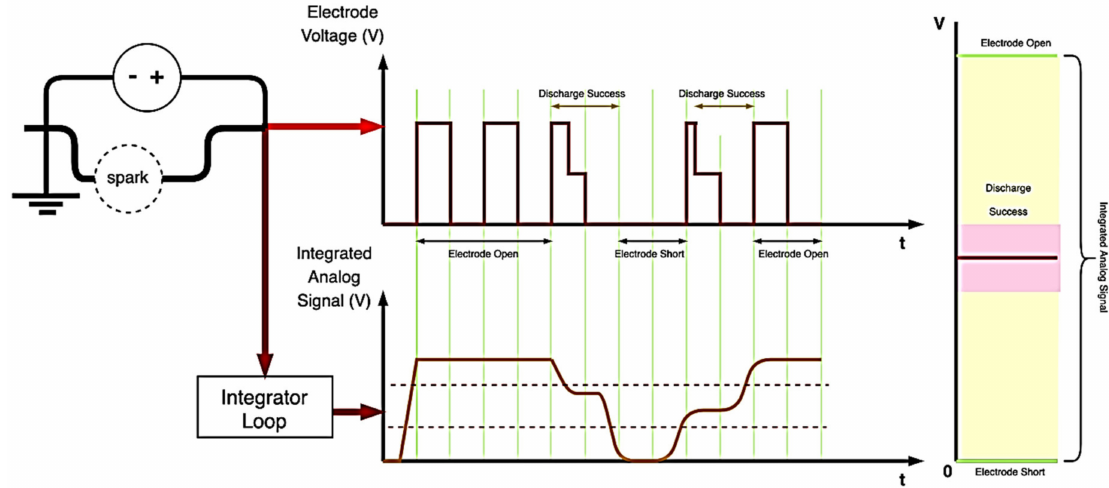
Figure 5. Schematic of discharge voltage signal